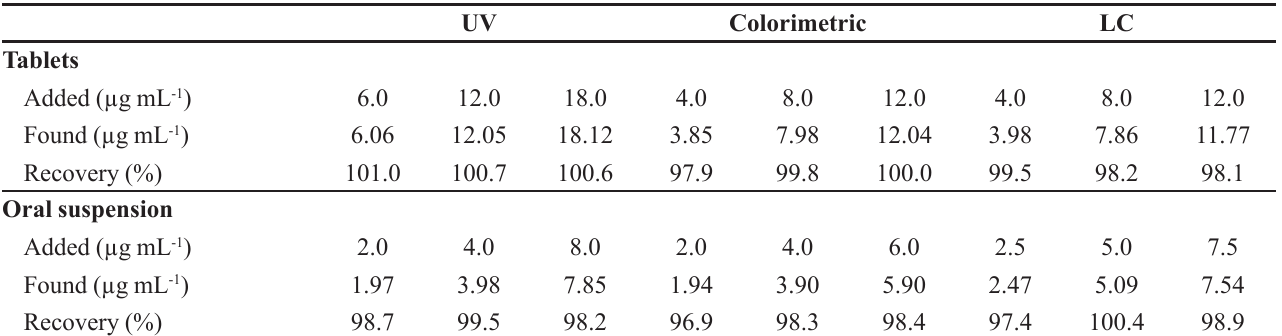
TABLE III - Accuracy of the evaluated methods for deflazacort